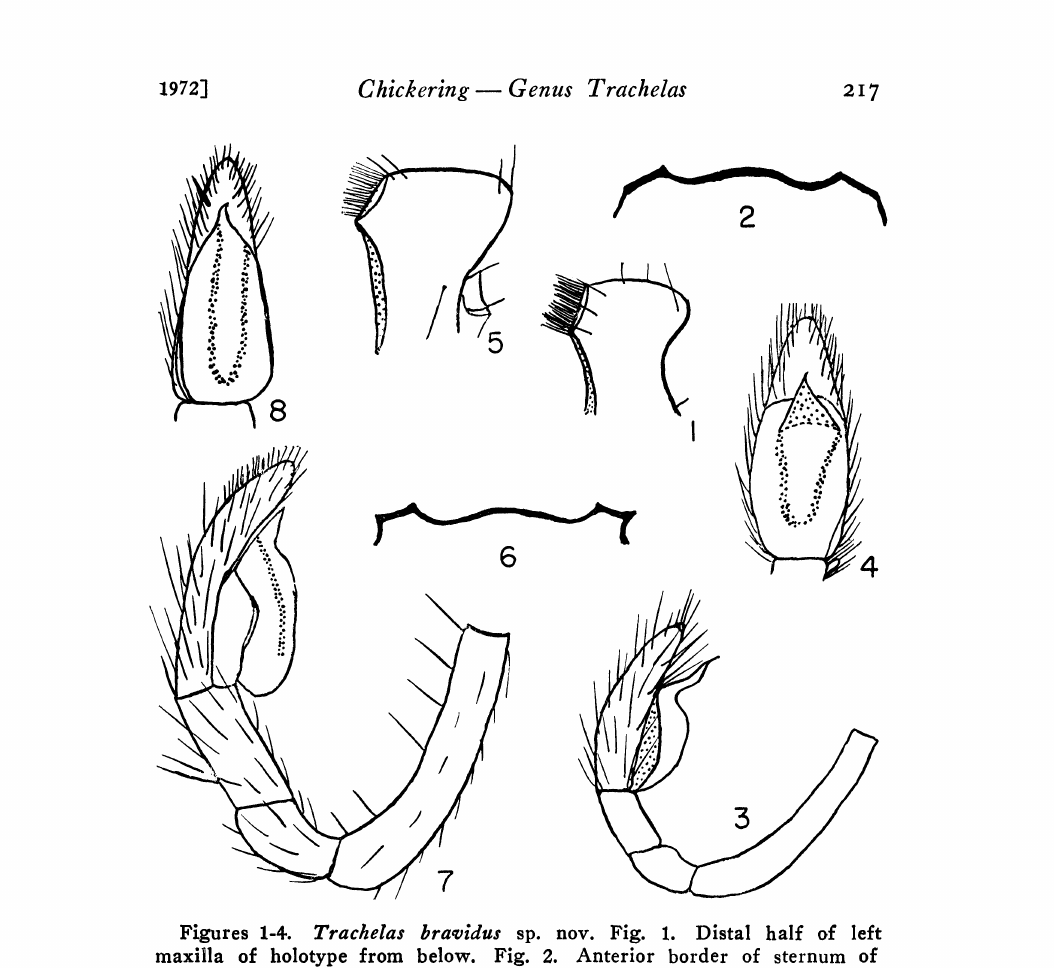
Figures 1-4. Trachelas braidus sp. nov. Fig. 1. Distal half of left maxilla of holotype from below. Fig. 2. Anterior border of sternum of holotype from below. Fig. 3. Left palp of holotype; prolateral view. Fig. 4. Left palpal tarsus of holotype; ventral view. Figures 5-8. Trachelas cadulus sp. nov. Fig. 5. Distal half of left maxilla from below. Fig. 6. Anterior border of sternum of holotype from below. Fig. 7. Left palp of holotype; prolateral view. Fig. 8. Left palpal tarsus of holotype; ventral